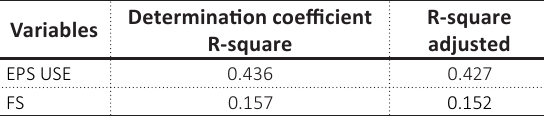
Table 6. Variations of the dependent variable explained by independent variables Variables Determination coefficient R-square